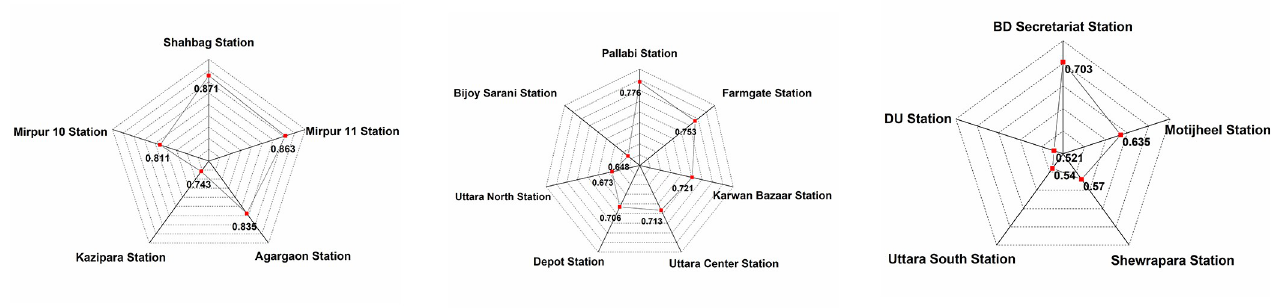
Fig 11. Ranking of stations based on max TOD index for (a) Top-ranked, (b) Medium-ranked, (c) Low-ranked stations.